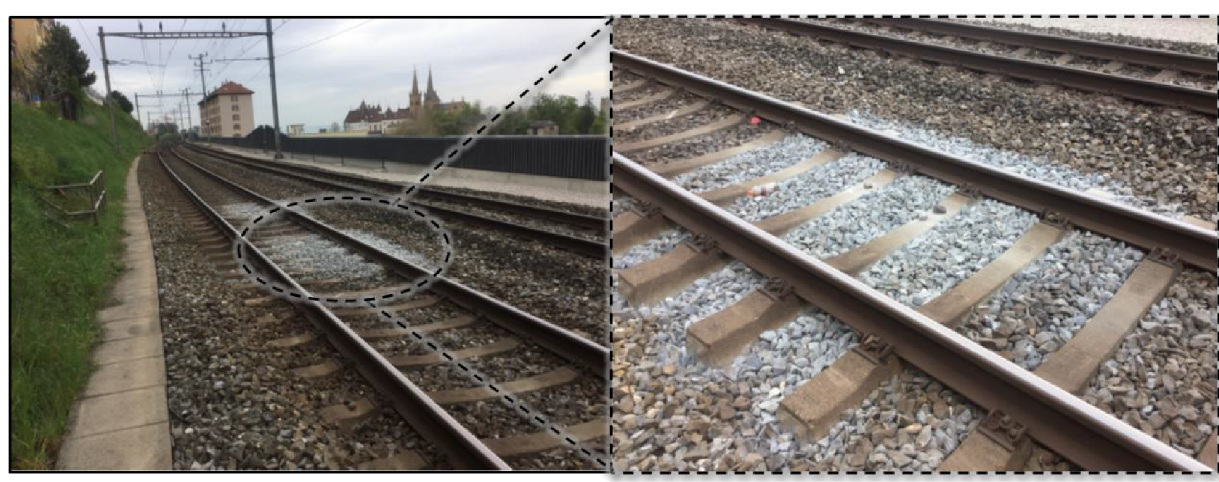
Fig. 1 White spots of ballast breakdown due to voided sleeper